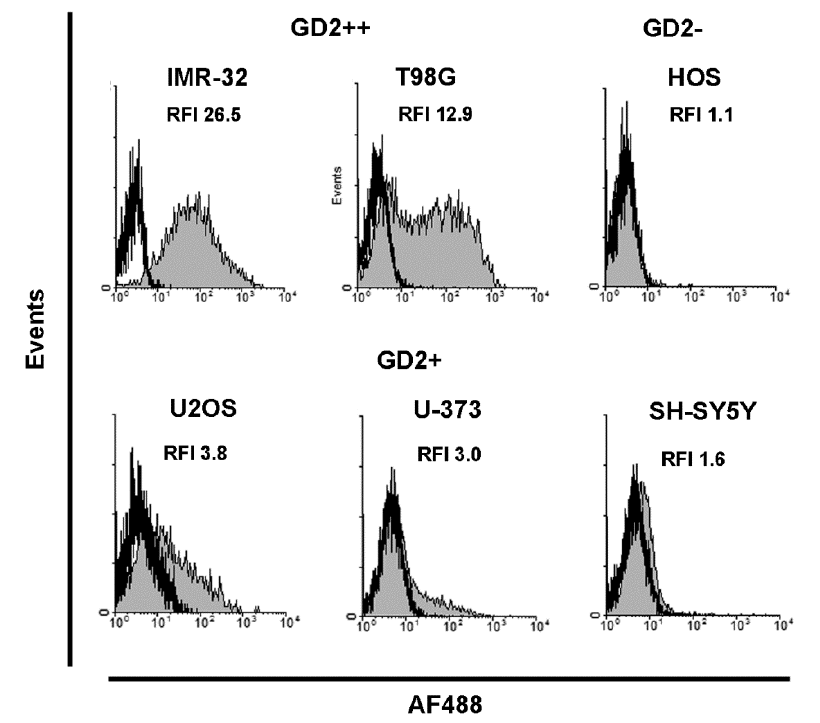
Figure 1. Ganglioside GD2 surface expression in cancer cell lines analyzed by flow cytometry. Gray histograms represent staining with anti-GD2 monoclonal antibodies, empty histograms represent autofluorescence of unstained cells. RFI (relative fluorescence intensity)—the ratio of specific fluorescence of cell staining with AF488-labelled antibodies 14G2a and autofluorescence of control unstained cells.